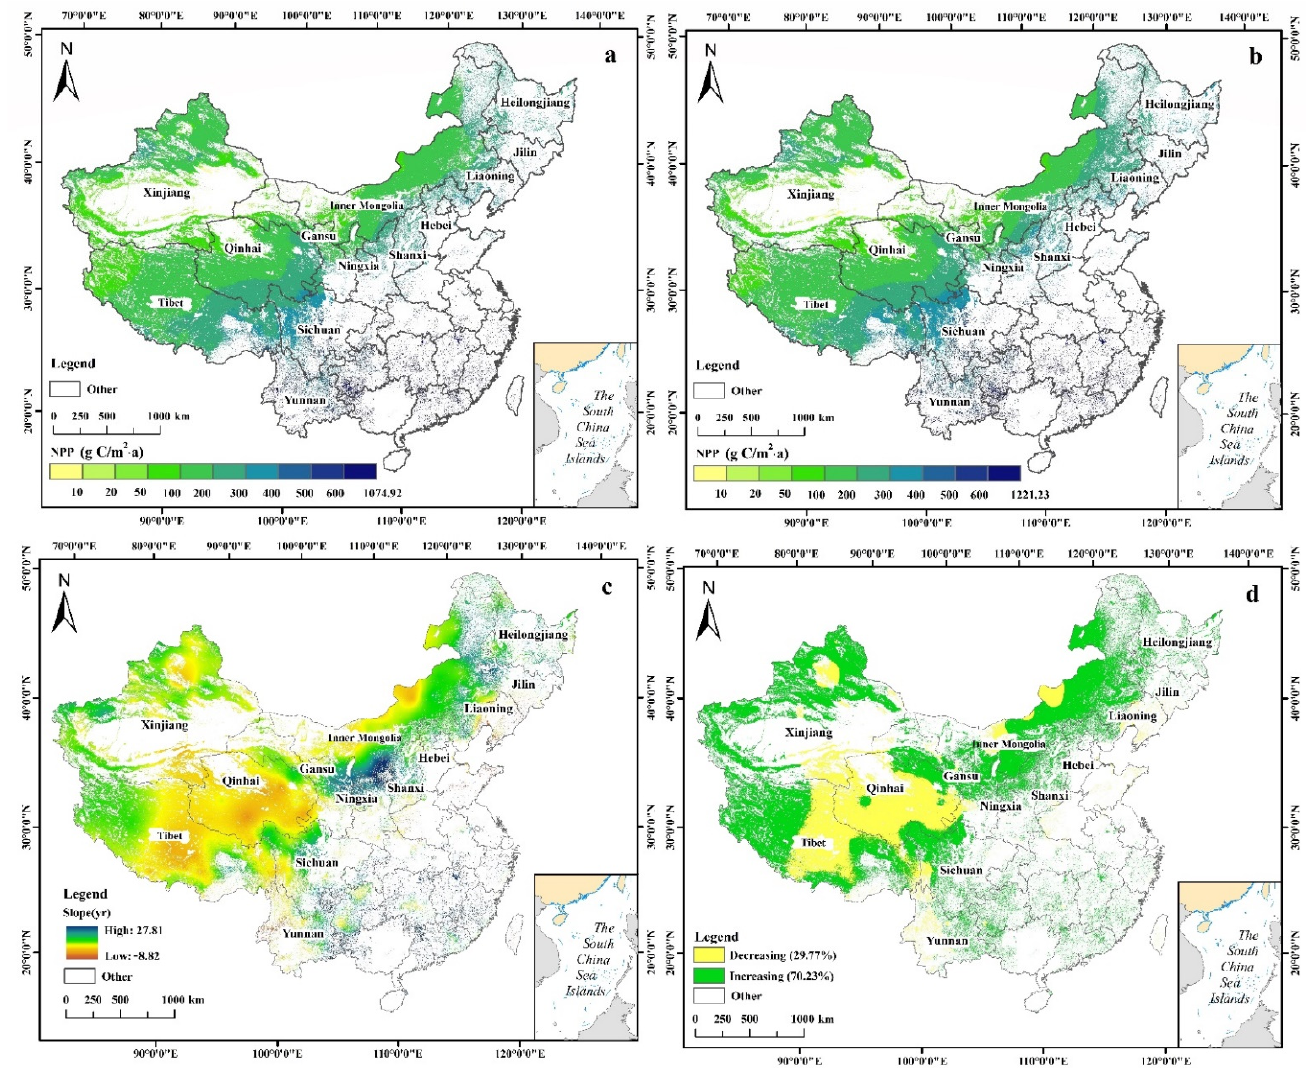
Figure 6. The spatial distribution and trend of the grassland climate NPP in China after (2004–2017) and before the implementation of the SISGC policy (2004–2010). ( a ) The average climate NPP (2004– 2010); ( b ) the average climate NPP (2011–2017); ( c ) trend change of the climate NPP; ( d ) trend